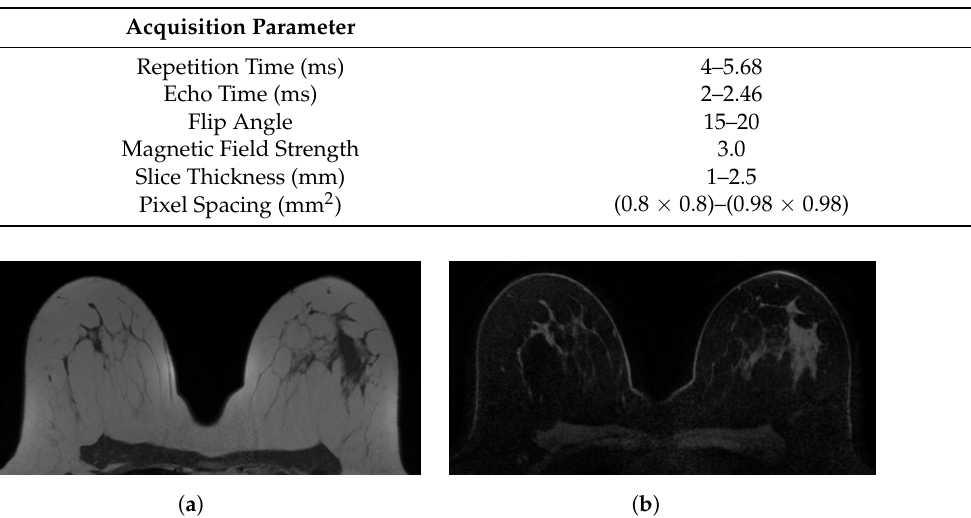
Figure 1. Examples of in-phase and reconstructed water Dixon acquisitions from our internal dataset used to mimic acquisitions without (WOFS) and with (FS) fat suppression. ( a ) In-phase Dixon acquisition used as WOFS image. ( b ) Reconstructed water Dixon acquisition used as FS image.